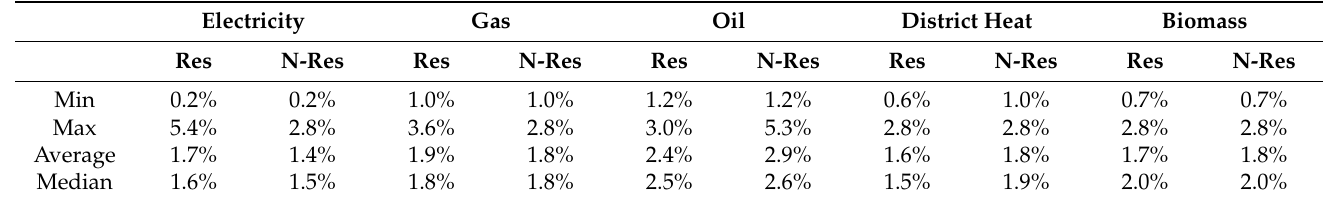
Table 3. Statistics about the annual increase in energy prices used for residential (Res) and non- residential (N-Res)